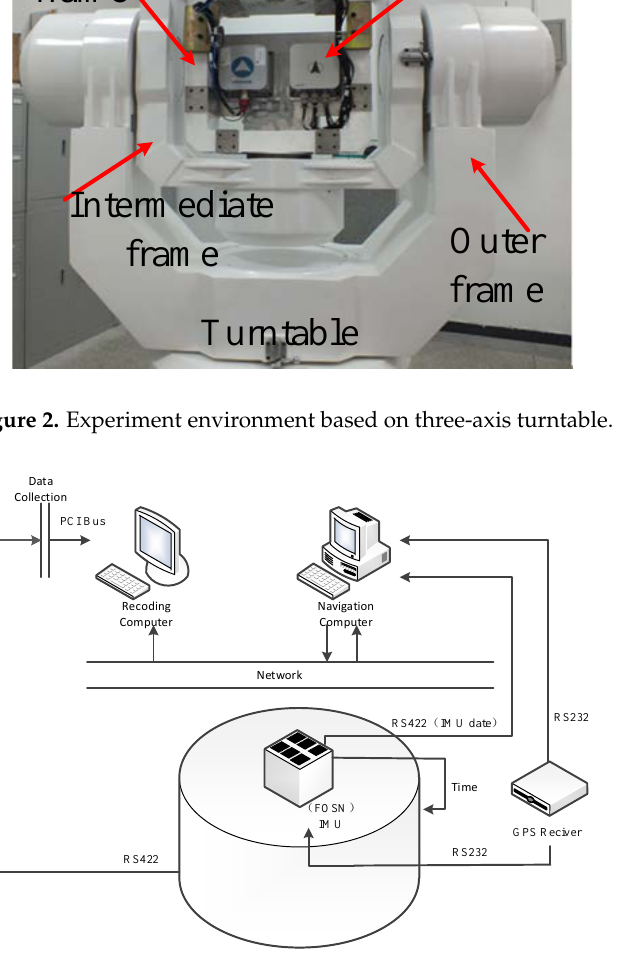
Figure 3. Structure diagram of experiment environment